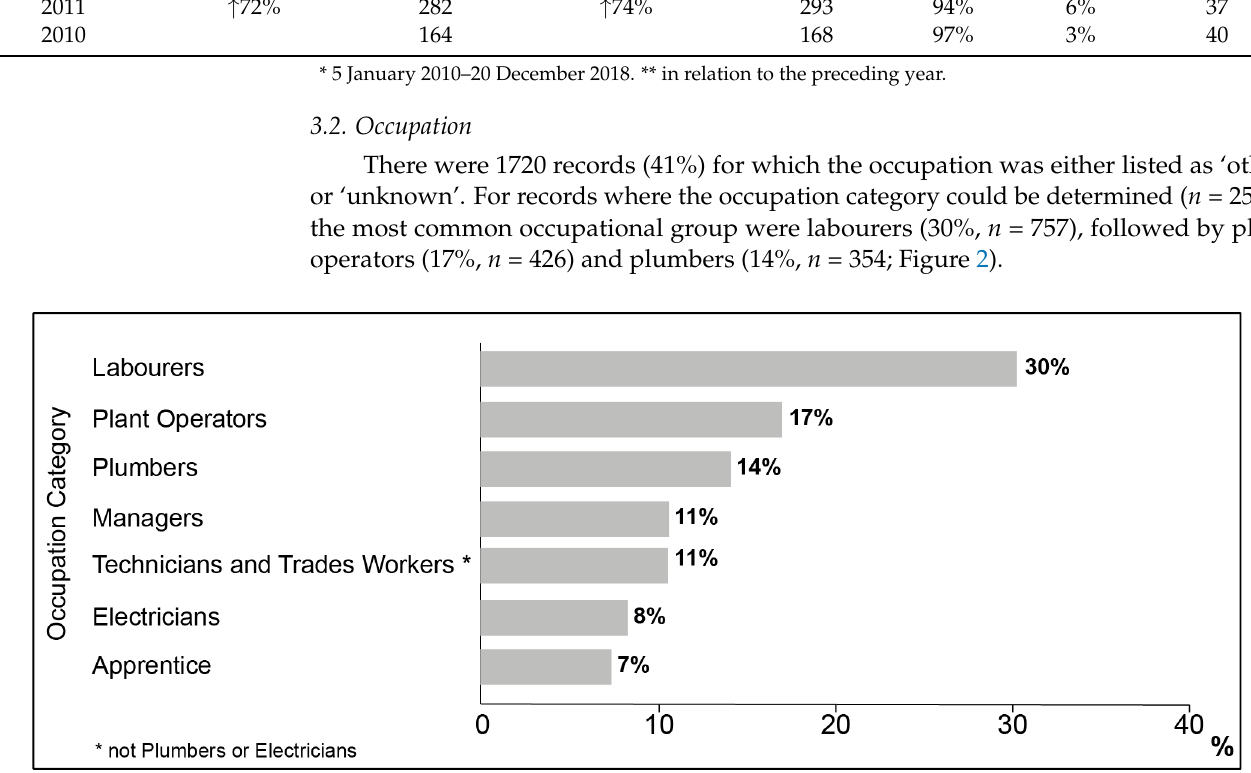
Figure 2. Distribution of occupation categories within the MATES case management database.